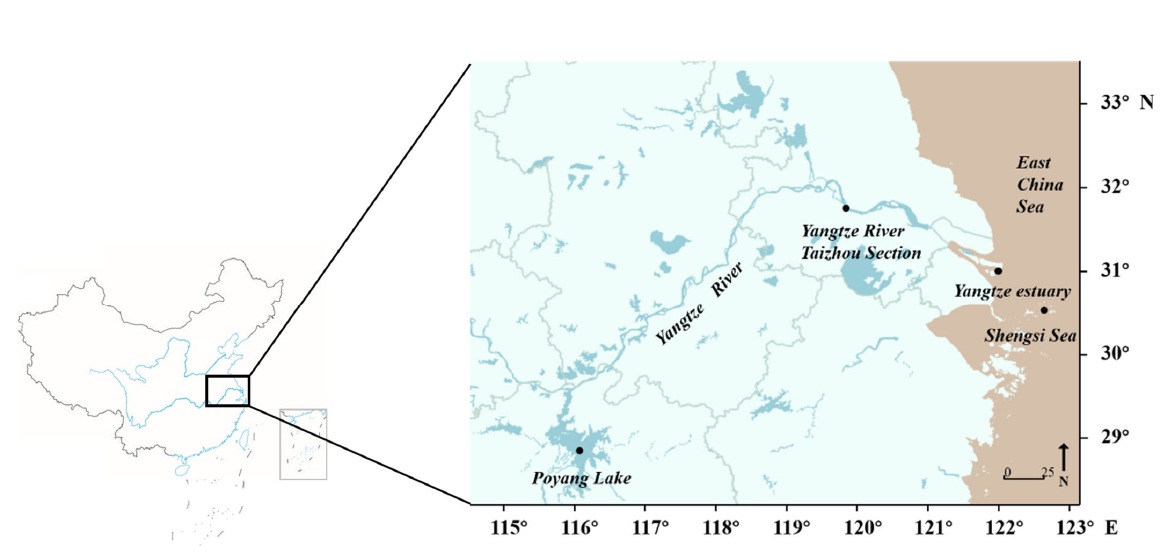
Figure 1. Sampling site map of Coilia